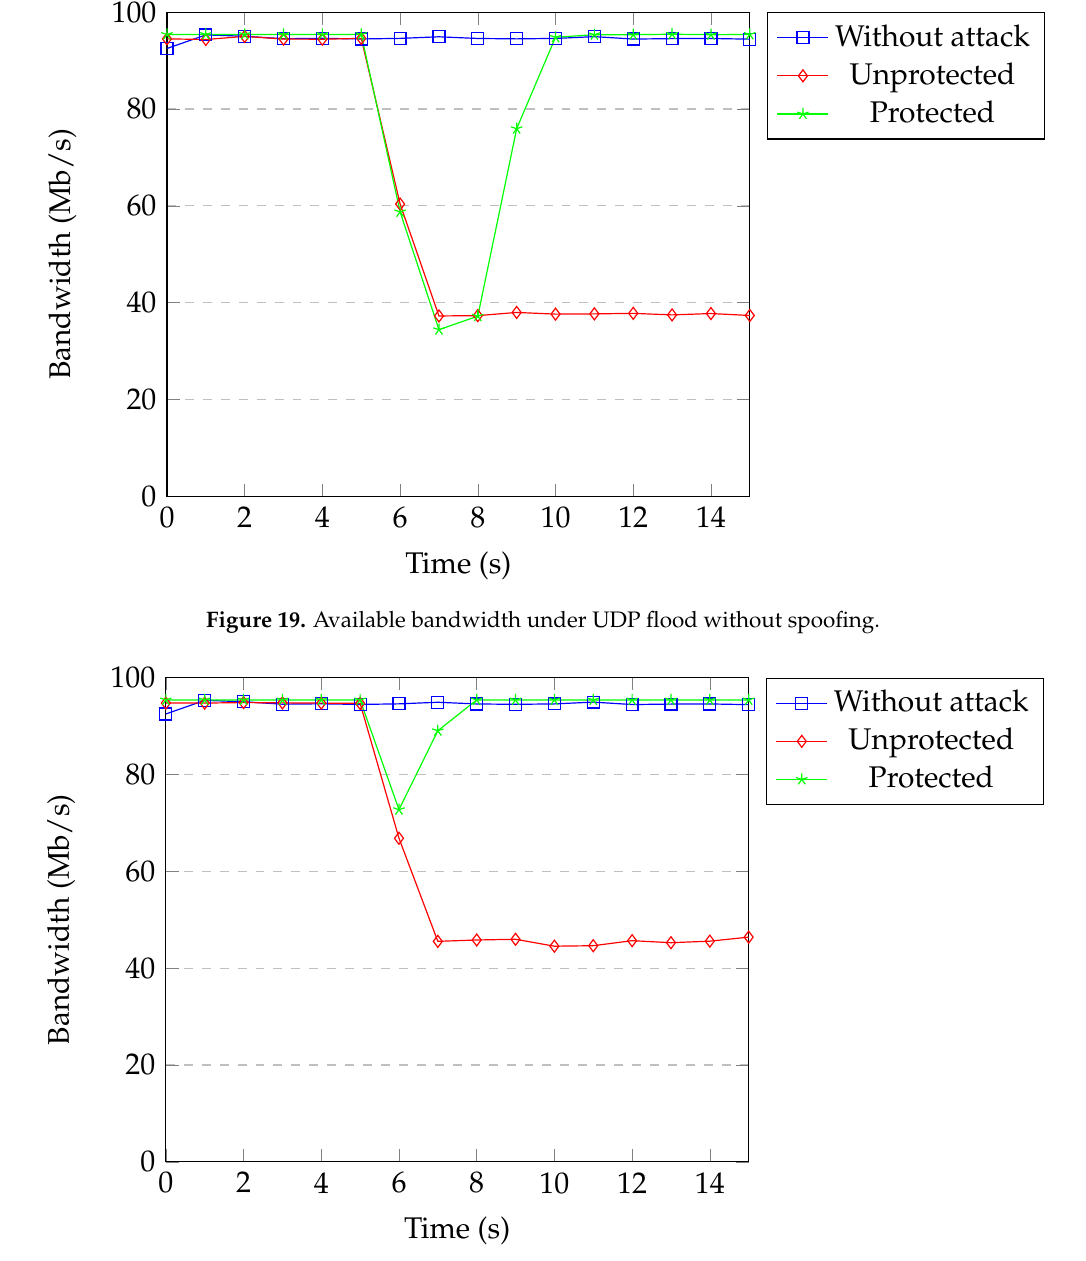
Figure 20. Available bandwidth under UDP flood with spoofing.